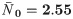
Initial distributions for population size N
0 and composition x
0 (parameter values N‾0=2.55, x‾0=0.45).The experimental distributions (bars) for N
0 (panel (a)) and x
0 (panel (b)) are measured from 120-well ensembles. The average N‾0 and x‾0 calculated from the measured values determine the parameters for the simulated distributions. The theoretical average distribution (solid blue line) is the average of the same distributions generated for 84 sets of 120 wells. Using that average we calculate the Wilson binomial confidence intervals (gray areas) for 68% (between dashed lines), 95% (between dotted lines) and 99.73% confidence. The measured and simulated distributions agree well within statistical error, confirming our assumption that individuals of strain A and B in the experiments start Poisson-distributed with mean N‾0x‾0 and N‾0(1−x‾0), respectively. The ragged distribution of x
0 derives from a small-number effect, and disappears at larger values of N
0 (see main text, and also S3 Fig).